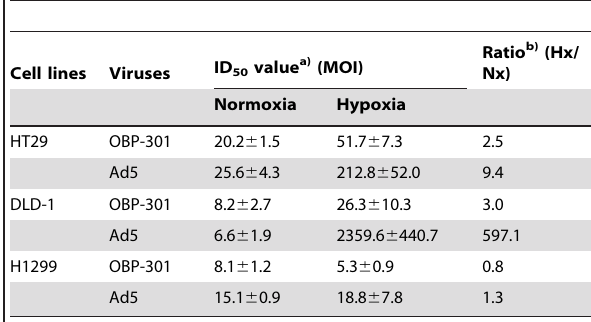
Table 1. Comparison of the ID 50 values of OBP-301 and Ad5 against human cancer cells under normoxia and hypoxia.